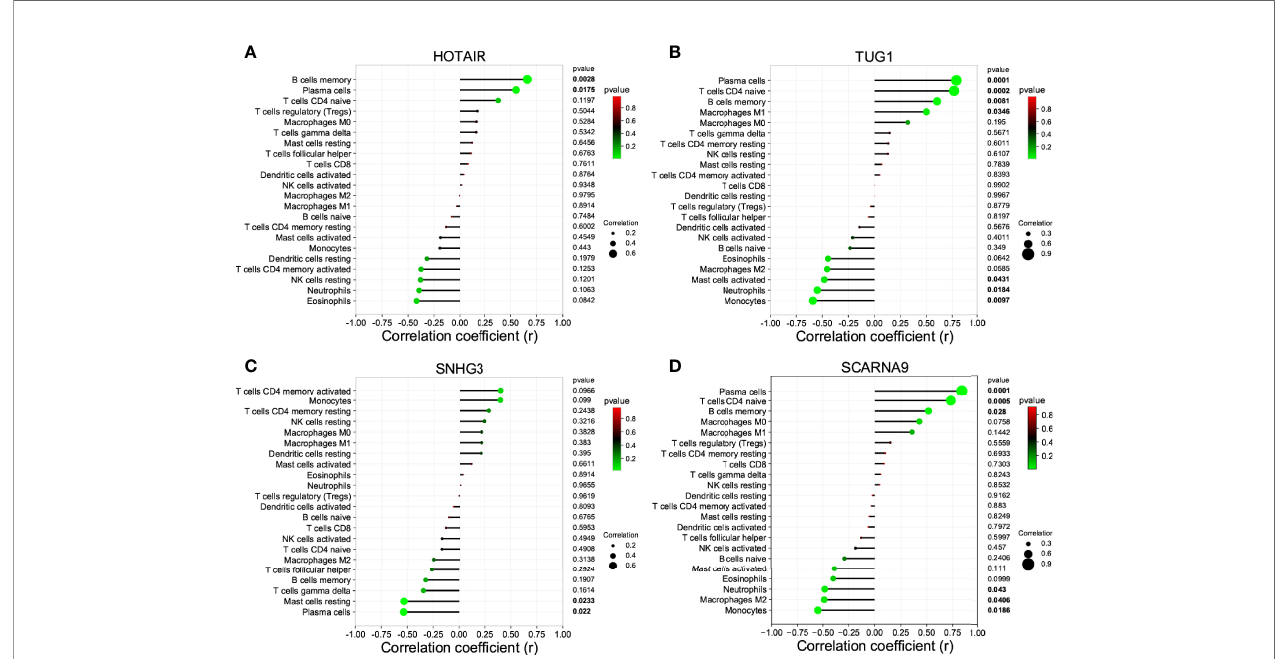
FIGURE 8 | The correlation between the lncRNA of ceRNA and immune cells. (A) HOTAIR; (B) TUG1; (C) SNG3; (D) SCARNA9.